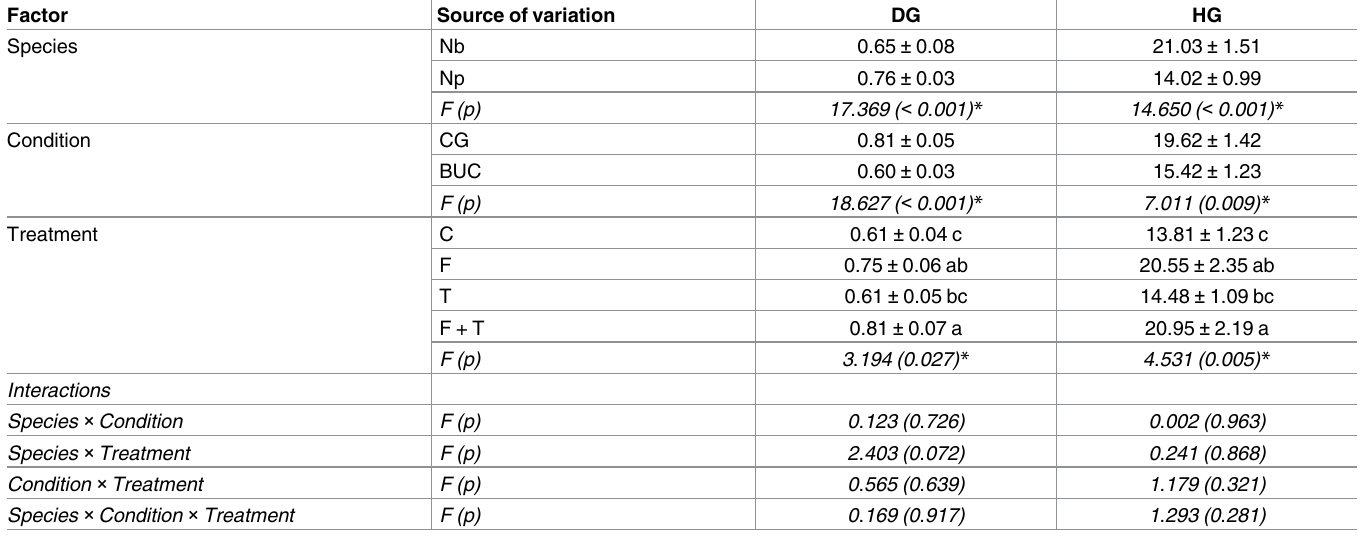
Table 3. Three-way ANCOVA for mean ( ± SE) diameter growth (DG) and height growth (HG) of seedlings per plot by species, canopy condition and treatment as main factors.